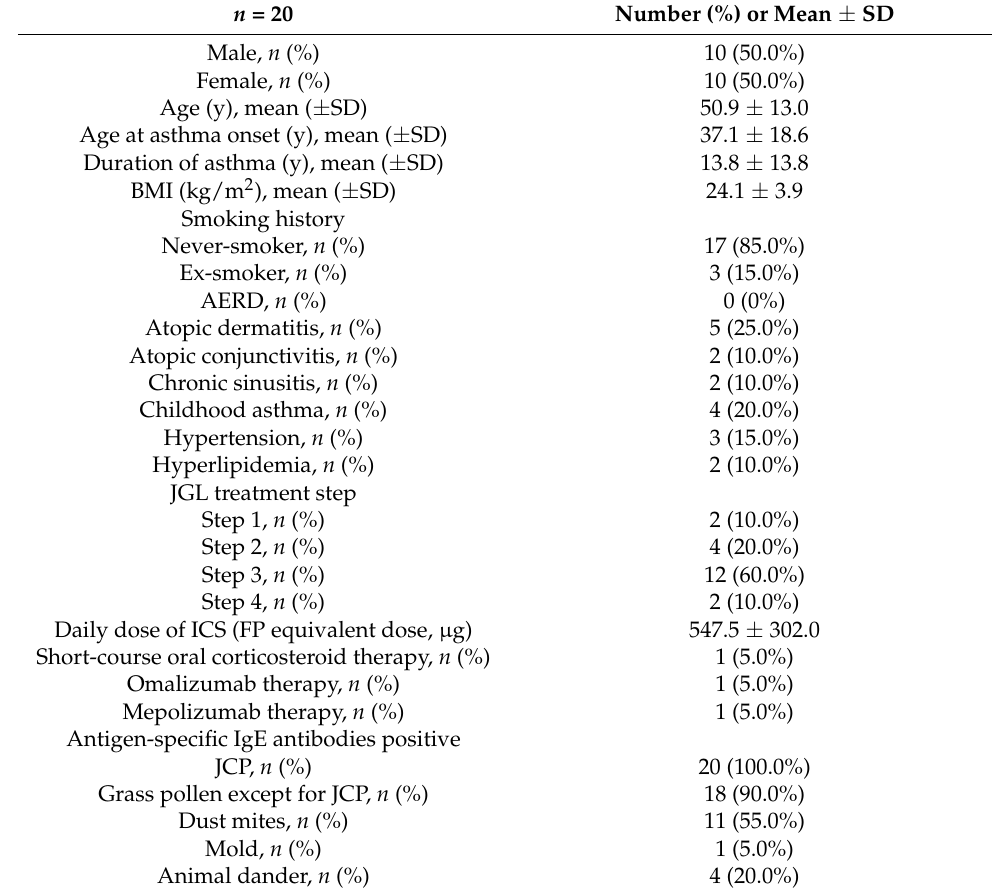
Table 1. Baseline characteristics of the study